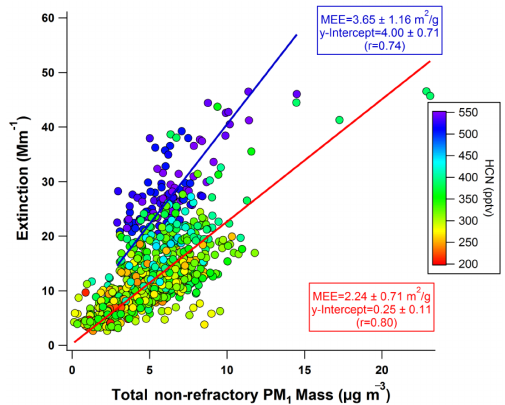
Figure 7. Orthogonal distance linear regression fits to extinction (Mm − 1 ) vs. total NR-PM 1 mass (µgm − 3 ) . Data points are color coded with the average HCN mixing ratio for non-biomass-burning and biomass burning